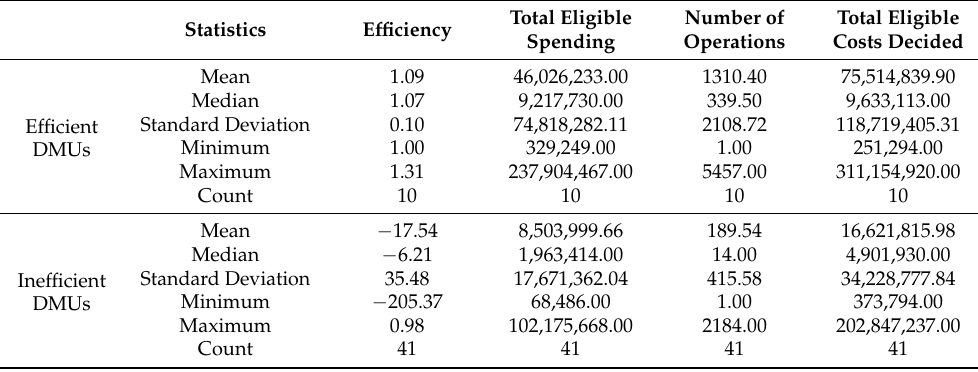
Table 6. Descriptive statistics of the results obtained both for efficient and inefficient